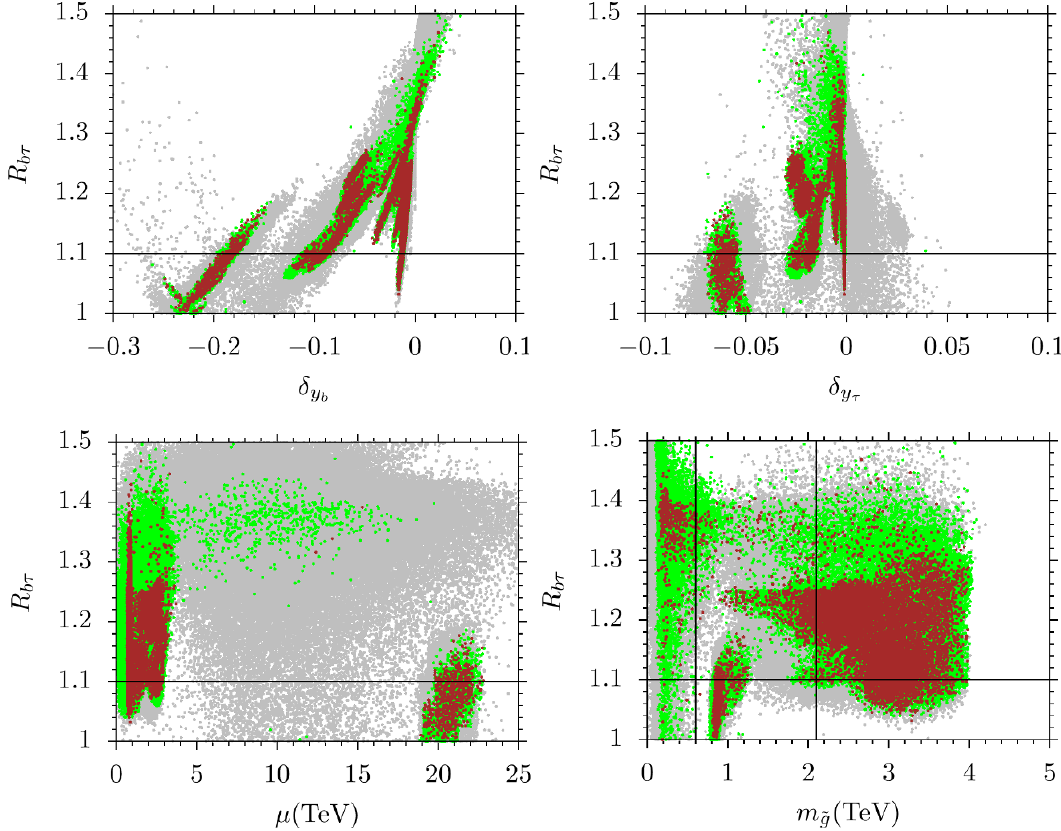
Figure 3 . Plots in the R b(cid:28) (cid:0) (cid:14) y same as in (cid:12)gure